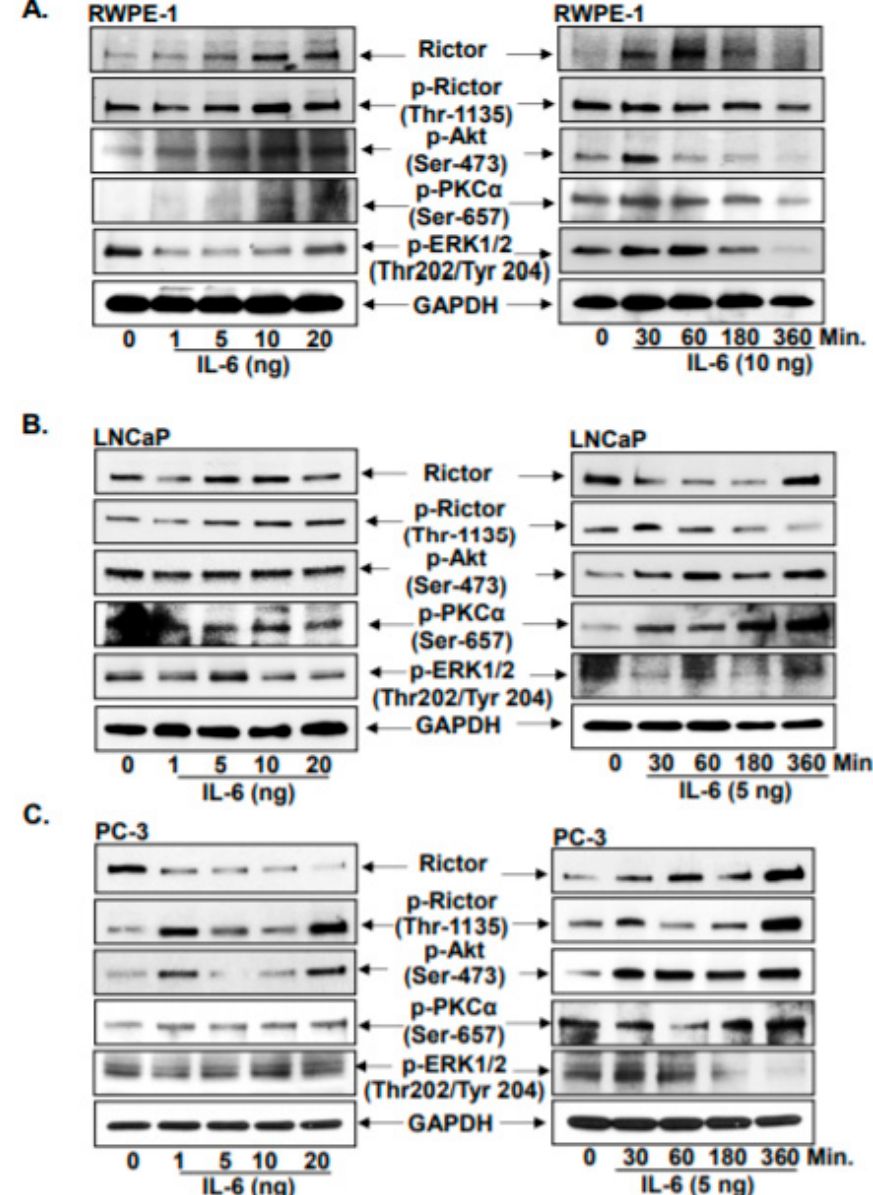
Figure 2. Pro-inflammatory cytokine IL-6 induced Rictor signaling cascade. Asynchronous ( A ) RWPE-1 normal prostate epithelial cells, ( B ) LNCaP (androgen sensitive), and ( C ) PC-3 (androgen refractory) cells were treated with IL-6 in increasing doses (1, 5, 10, 20 ng) and time (30, 60, 180, 360 minutes) exposure, and later subjected to total cell lysate and western blot analysis. Protein resolved in SDS page gels were Rictor, p-Rictor (Thr-1135), p-AKT (Ser-476), p-PKC α (Ser-657), and p-ERK1/2 (Thr202/Tyr 204). Lanes mentioned as ‘0’ are PBS control-treated cells. For protein, control blots were stripped and reprobed with GAPDH.